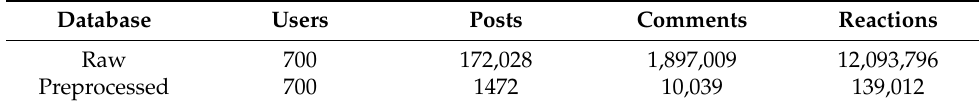
Table 1. The data collected from June to December 2019 in fashion.